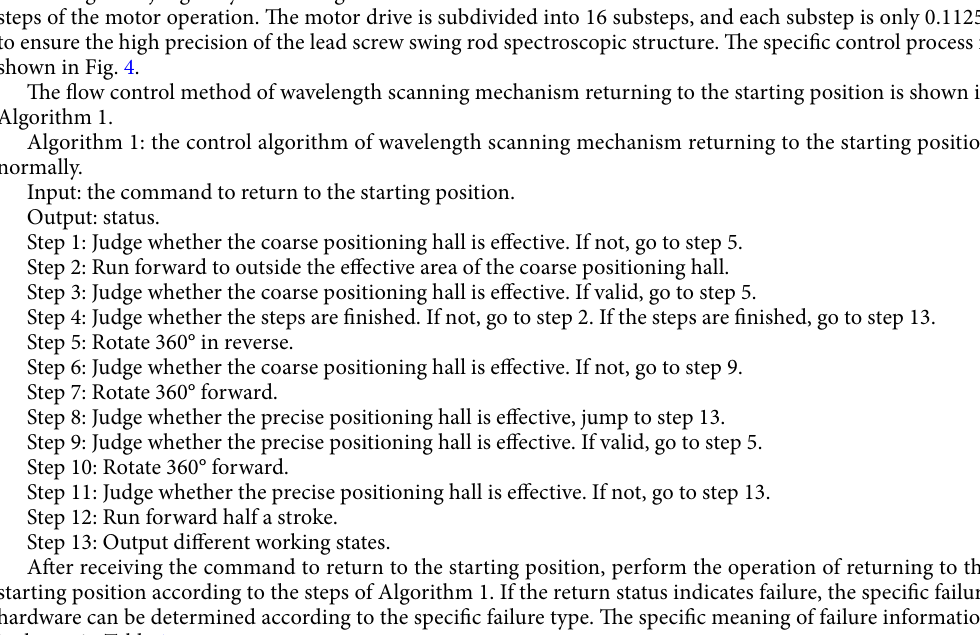
Algorithm 1. Algorithm 1: the control algorithm of wavelength scanning mechanism returning to the starting position